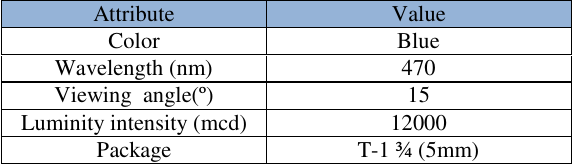
Table 1 . Main characteristics of the HLMP-CB1A-XY0DD LED used in the Nanobeacon